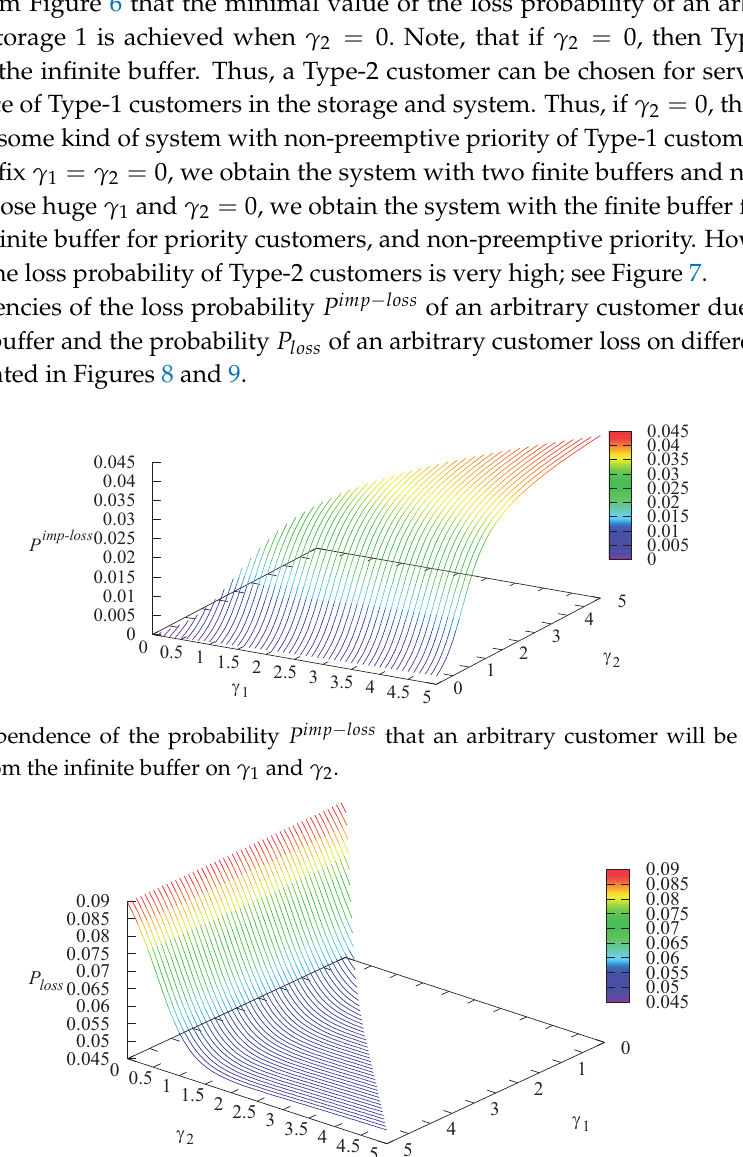
Figure 7. Dependence of the probability P loss on γ 1 and γ 2 .